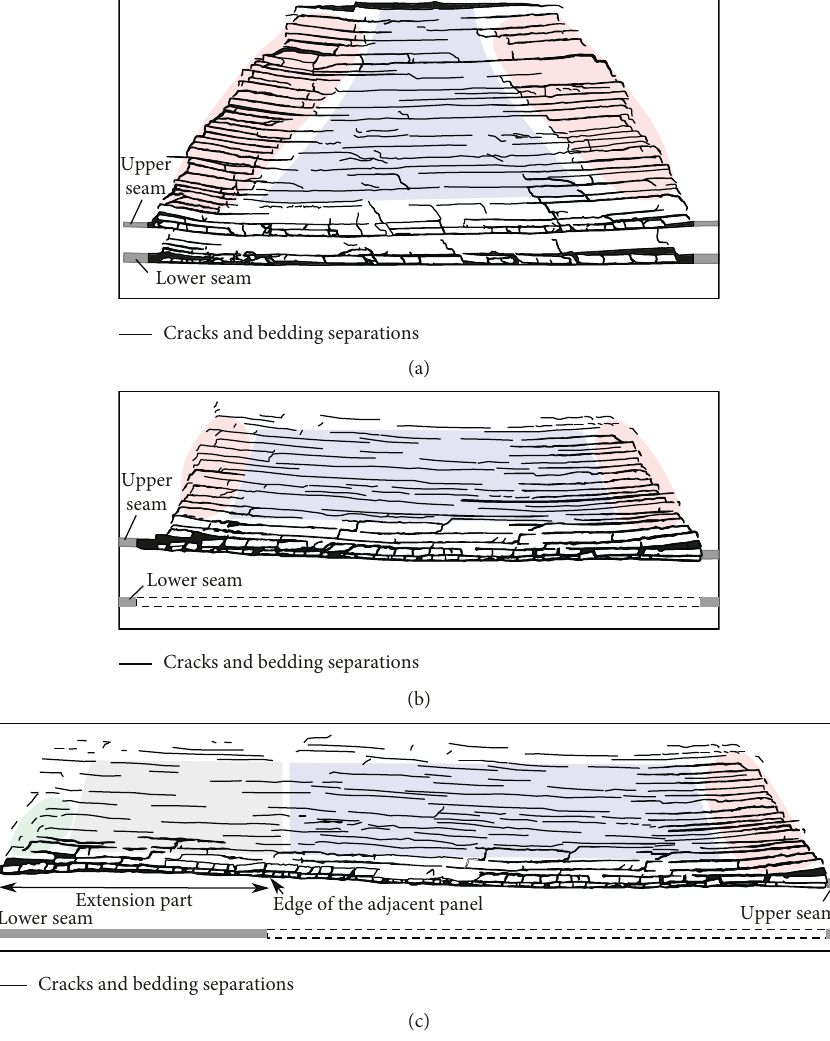
Figure 14: Interstrata and horizontal fractures after multiseam extraction in (a) Case 1, (b) Case 2, and (c) Case